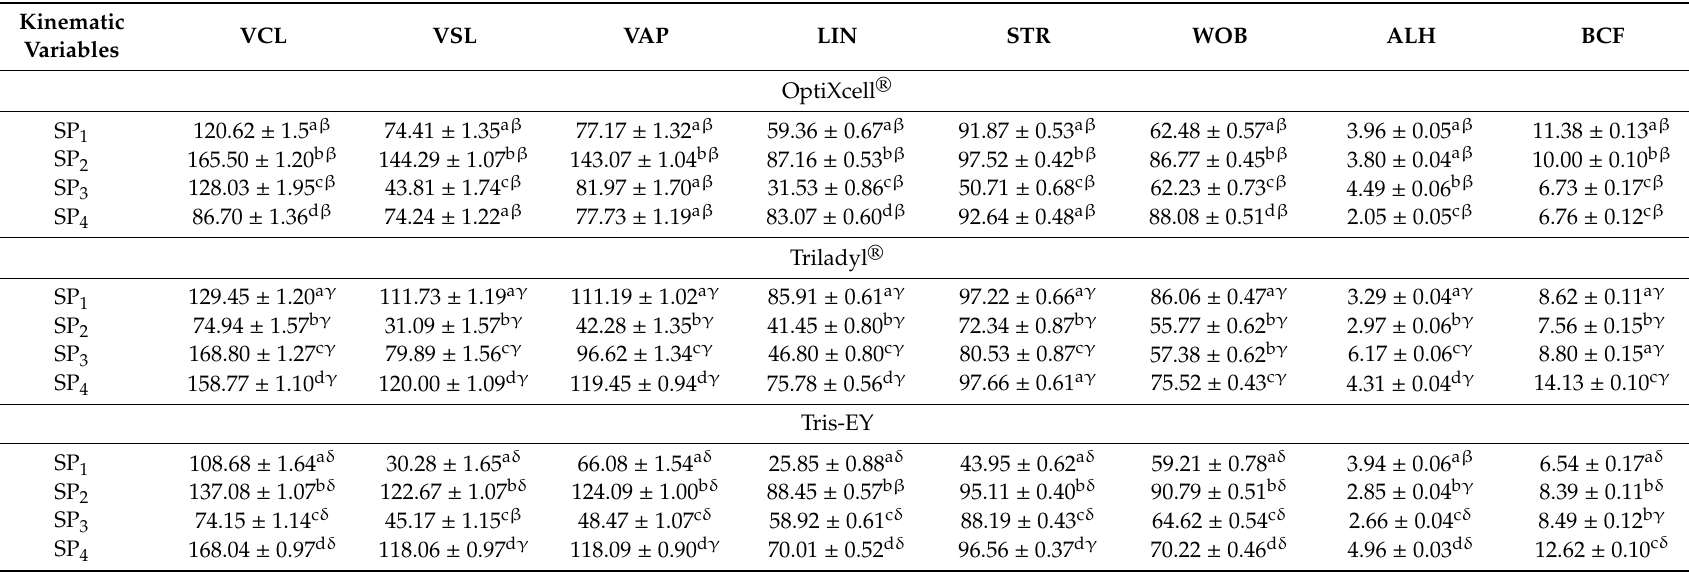
VCL = curvilinear velocity ( µ m · s − 1 ); VSL = straight-line velocity ( µ m · s − 1 ); VAP = average path velocity ( µ m · s − 1 ); LIN = linearity of forward progression (%); STR = straightness (%); WOB = wobble (%); ALH = amplitude of lateral head displacement ( µ m); BCF = beat-cross frequency (Hz); SP: subpopulation; SEM = standard error of the mean. Number of cells = 6493. a-d Within the same column and extender, di ff erent superscripts indicate di ff erences among sperm SPs. βγδ Within the same column and SP, di ff erent superscripts indicate di ff erences among extenders. p <